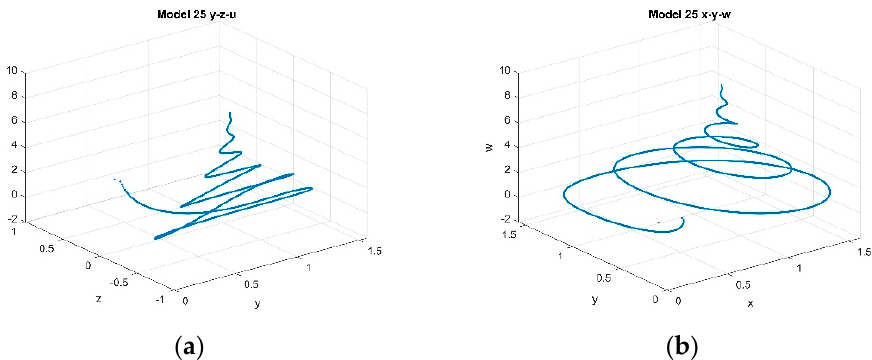
Figure 26. Phase portraits ( a ) y − z − u , ( b ) x − y − w , at h = 0.002, k = 2, p = 1, α 5 = 0.24 for models (22) through (25).